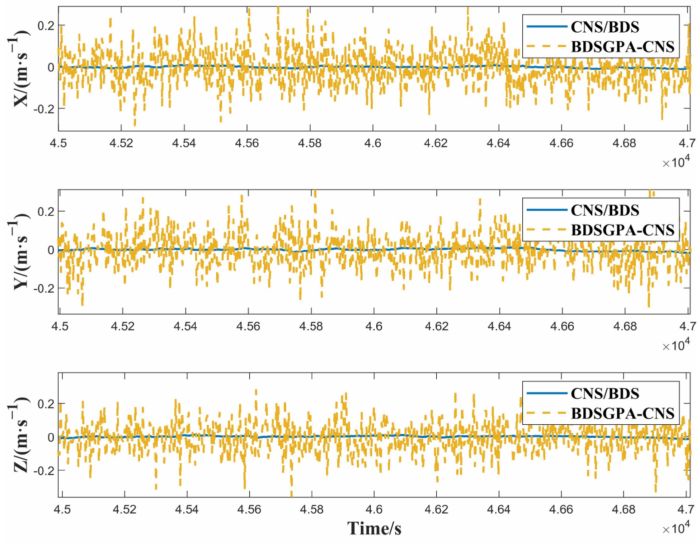
Figure 13. Local velocity error in three directions. Table 7. RMSEs for position and velocity in each direction when both methods are available.